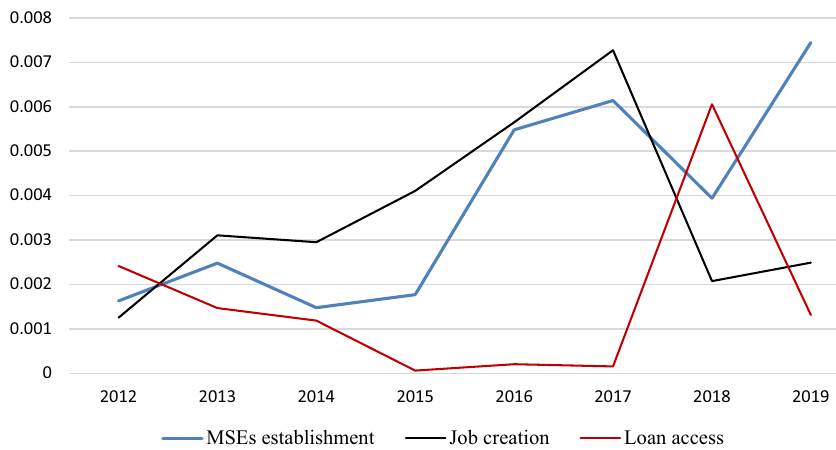
Fig. 2 Position of MSEs in BGRS relative to enterprise at national